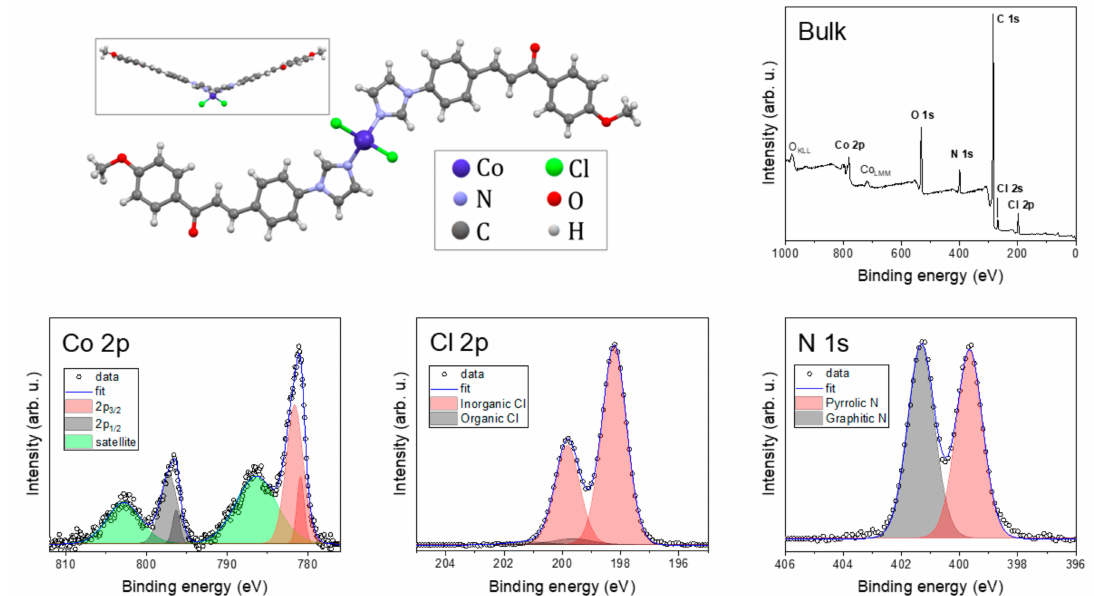
Figure 5. Molecular structure with survey XPS spectrum and detailed Co 2p, Cl 2p, and N 1s